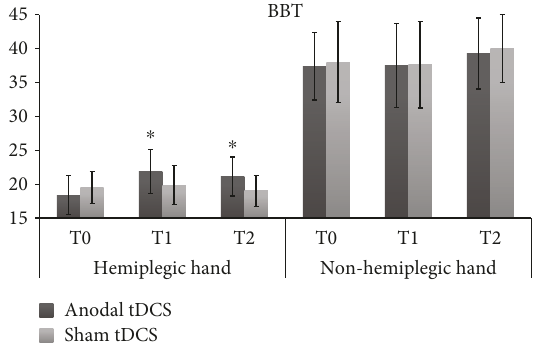
Figure 3: HGS scores(i.e., mean voluntaryisometric strength, in kg) for the hemiplegic and nonhemiplegic hands, at each assessment of the real anodal tDCS and sham tDCS sessions. T0 =baseline; T1 =immediately after the end of tDCS; T2 =90min after the stimulation session.